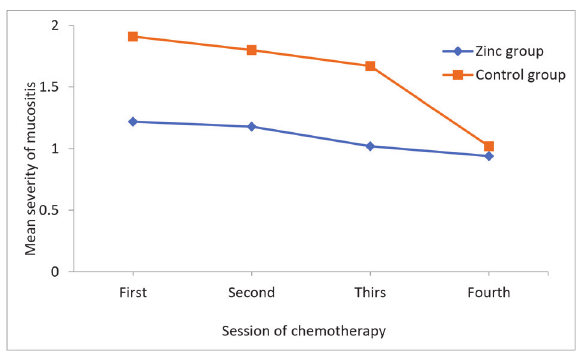
Figure 2. Linear diagram of the mean severity of chemotherapy-induced oral mucositis in the two